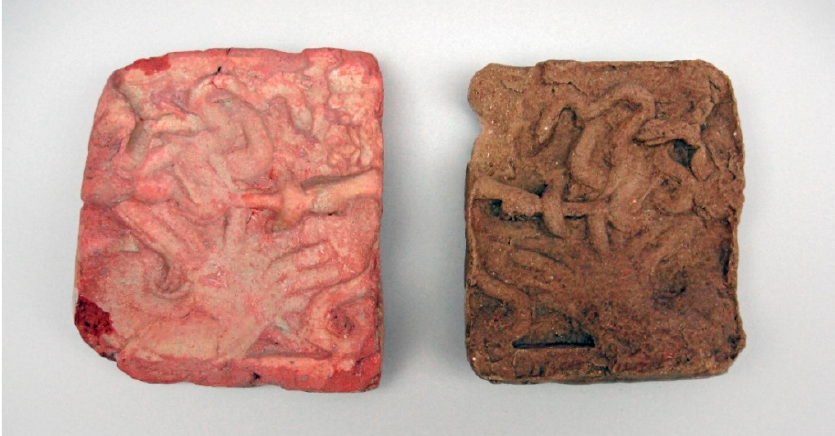
Figure 6. Partially preserved scene depicting the killing of the Lernaean Hydra (MGW inv. no. 3193); terracotta mold; ca. 6th century BCE .